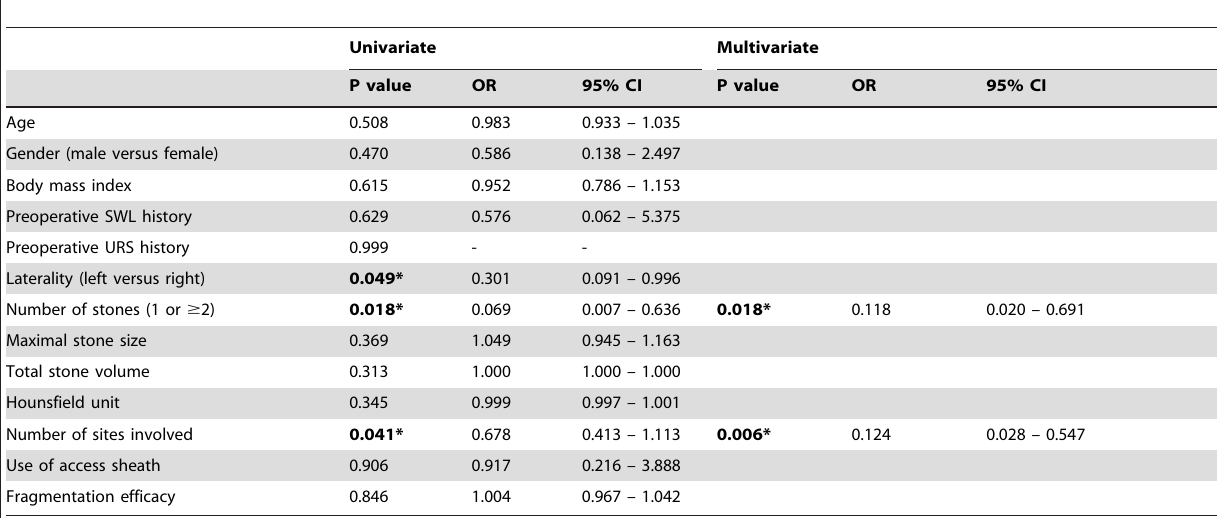
Table 3. Uni- and multivariate logistic regression analysis to predict clinically stone-free status.